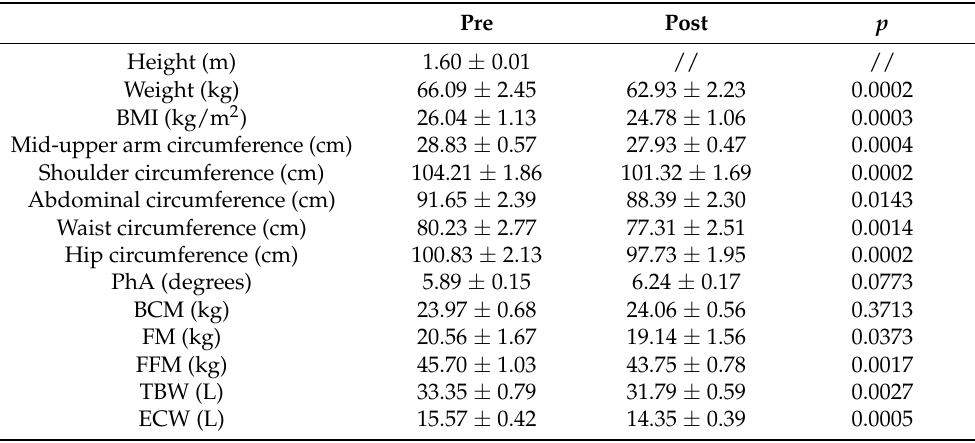
Table 2. Anthropometric and bioelectrical impedance characteristics of IBS-D patients before (pre) and after (post) 12 weeks of a Tritordeum-based